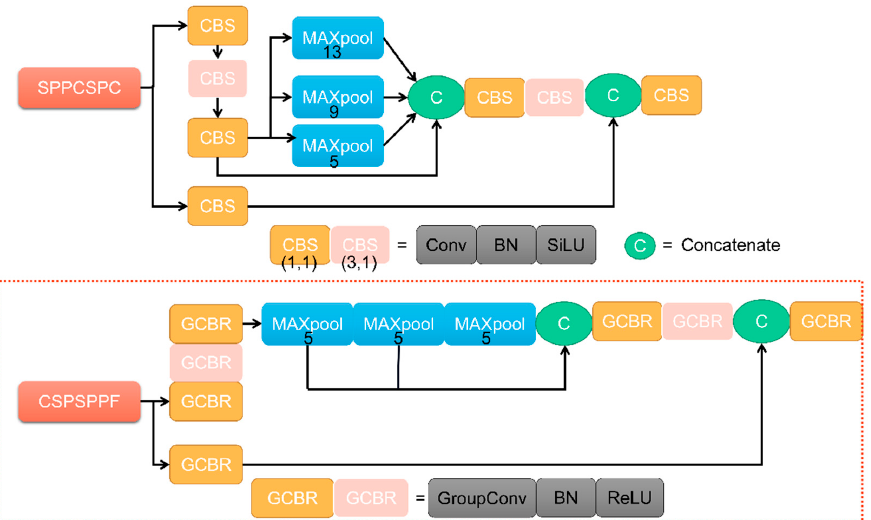
Figure 5. An illustration of the structure of CSPFSA Block. In the figure, the structure of CSPNet is still used to enrich the gradient information and reduce the amount of computation, where the upper part is the original structure of a common residual block, the features of the lower part perform the calculation of self-attention and channel attention. An illustration of the structure of CSPSPPF comparison with the SPPCSPC structure. It can be seen that pooling layers of different sizes in parallel of SPPCSPC are replaced by pooling layers of the same size in series in CSPSPPF. The pink convolutional block represents 3 × 3 convolutional kernel with a stride of 1. The orange convolution block represents 1 × 1 convolution kernel with a stride of